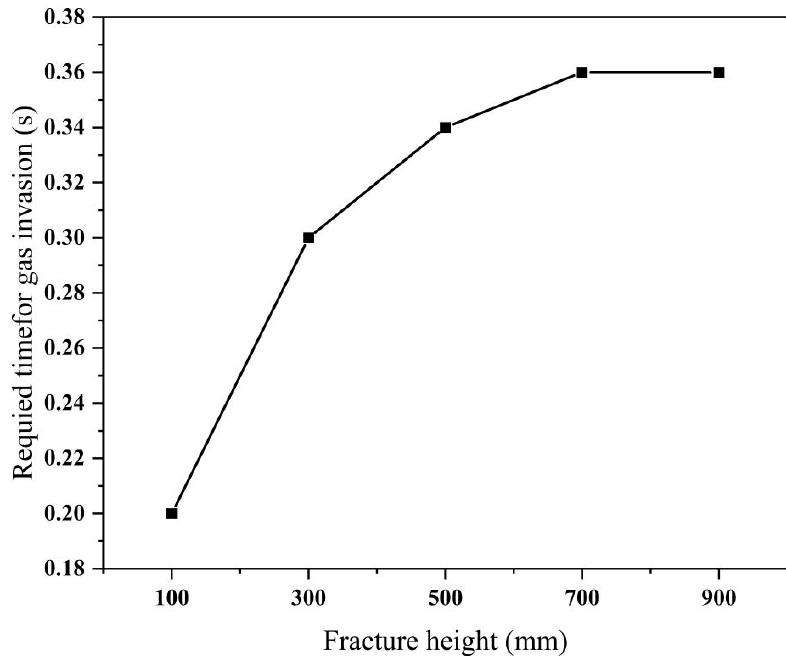
Figure 15. Time required for gas invasion at different fracture heights.